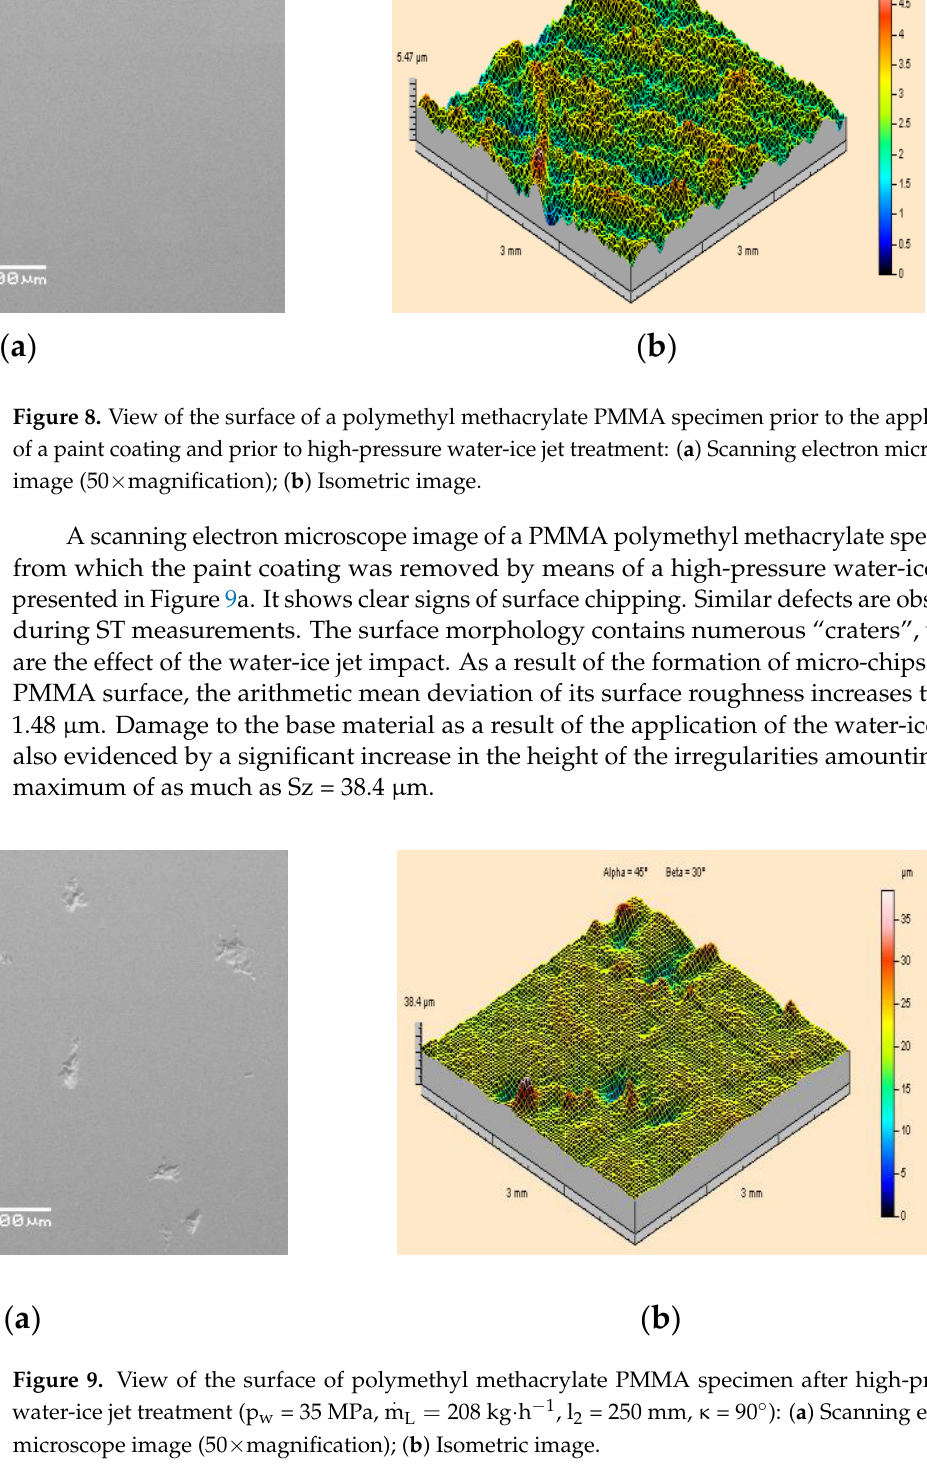
Figure 9. View of the surface of polymethyl methacrylate PMMA specimen after high-pressure = 208 kg·h −1 , l 2 = 250 mm, κ = 90°): ( a ) Scanning electron water-ice jet treatment (p w = 35 MPa, ṁ L microscope image (50×magnification); ( b ) Isometric image. Reducing the working pressure of the jet to 20 MPa and the dry ice output to a maximum of 𝑚̇ 𝐿 = 156 kg·h −1 enabled an effective paint stripping tool to be obtained. At the same time, the applied treatment did not cause damage to the substrate surface. A